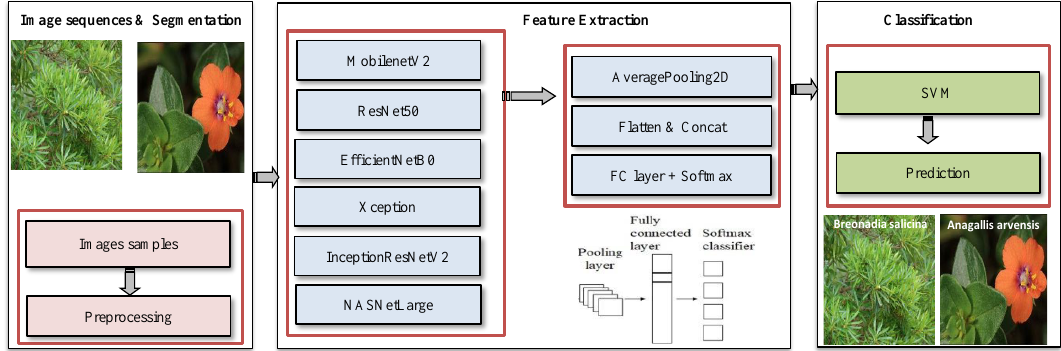
Figure 1. Estimating the types of plants with the proposed